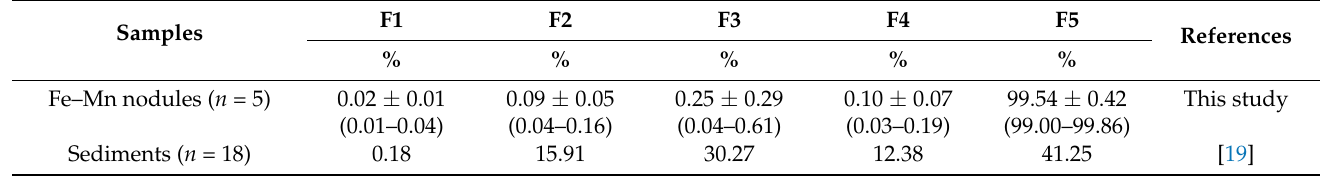
Table 3. Distribution of arsenic in geochemical fractions of the FMNs.